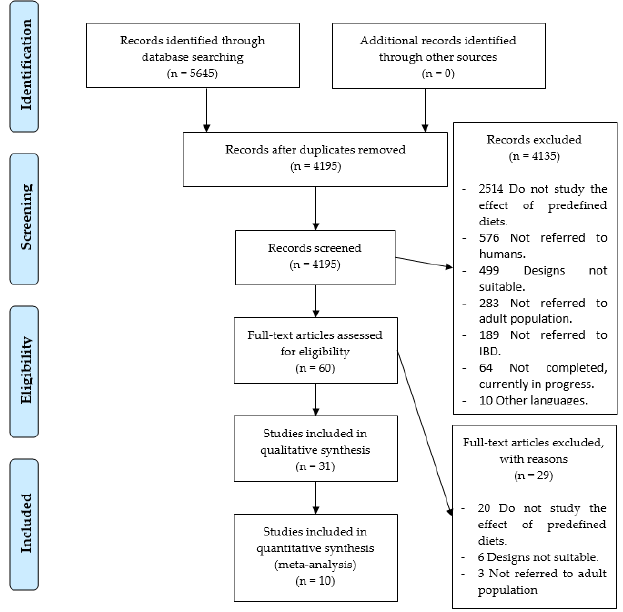
Figure 1. Identification and selection of studies/records in the databases.